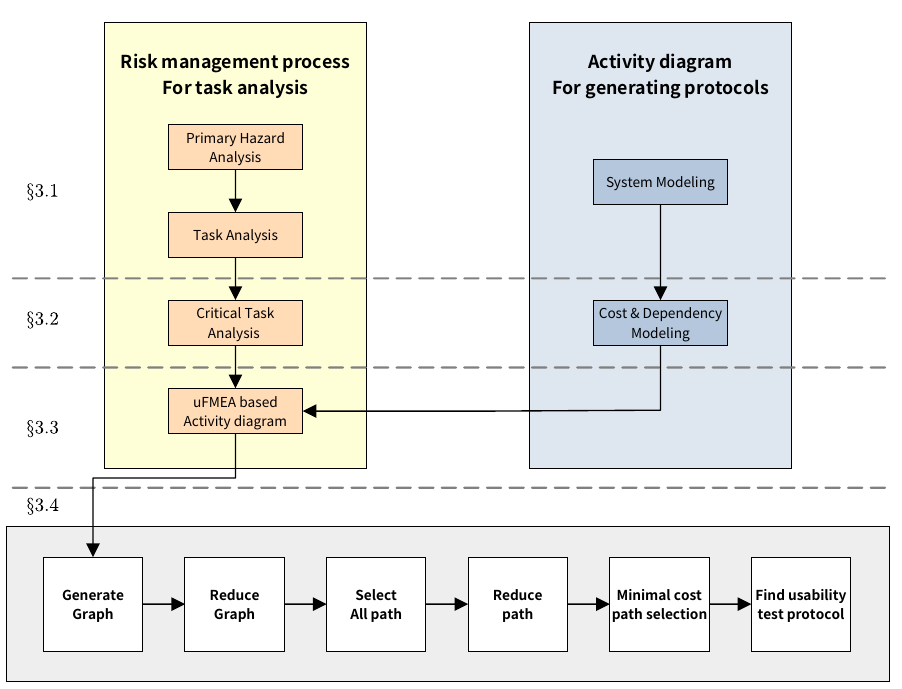
Figure 1. Overall process for deriving a time-cost effective usability test